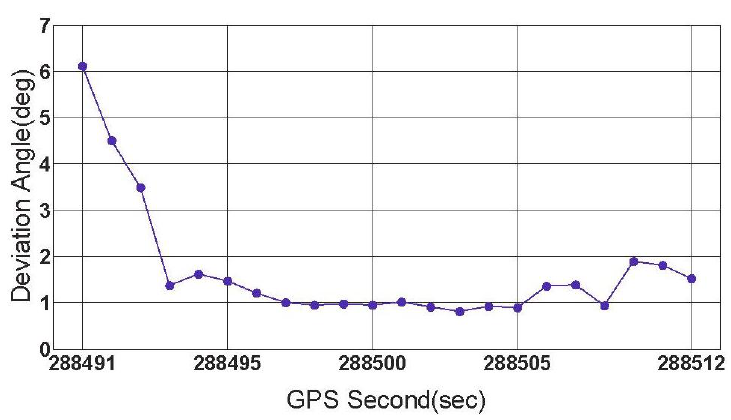
Figure 9.  s for data section